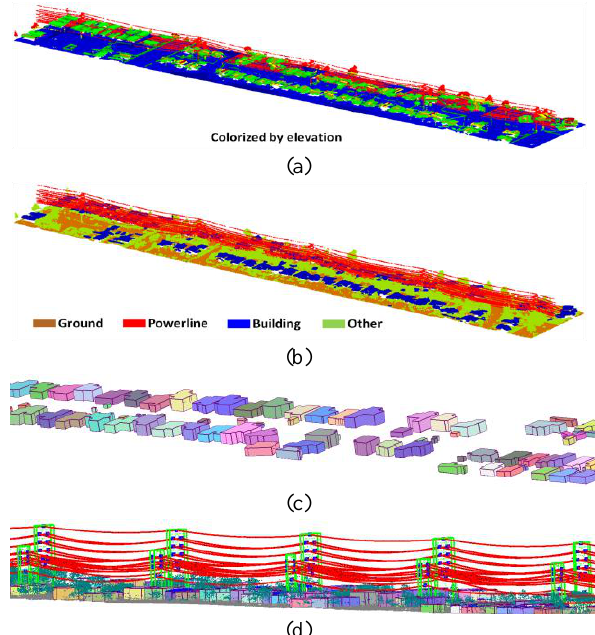
Figure 7. (a) Raw airborne laser scanning data set, (b) PL scene segmentation, (c) Prismatic building reconstruction, and (d) 3D PL structure’s reconstruction: PLs (red colour) and pylons (green